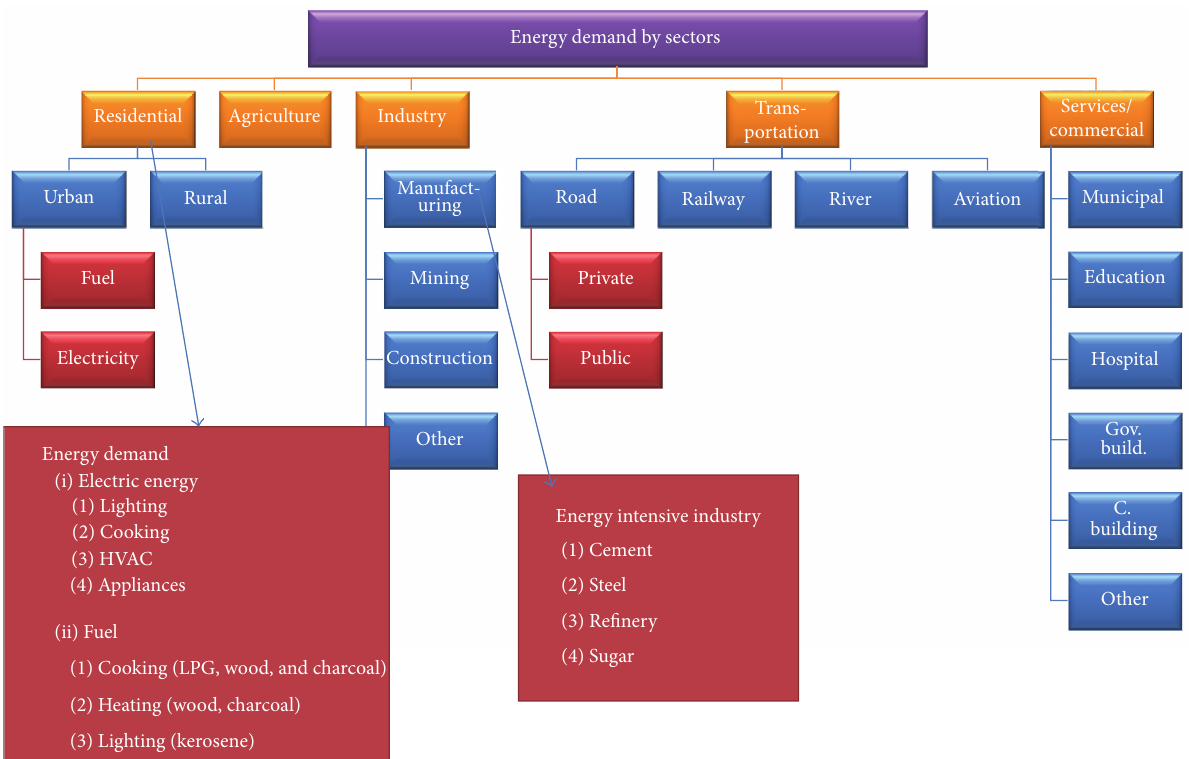
Figure 3: Energy demand by